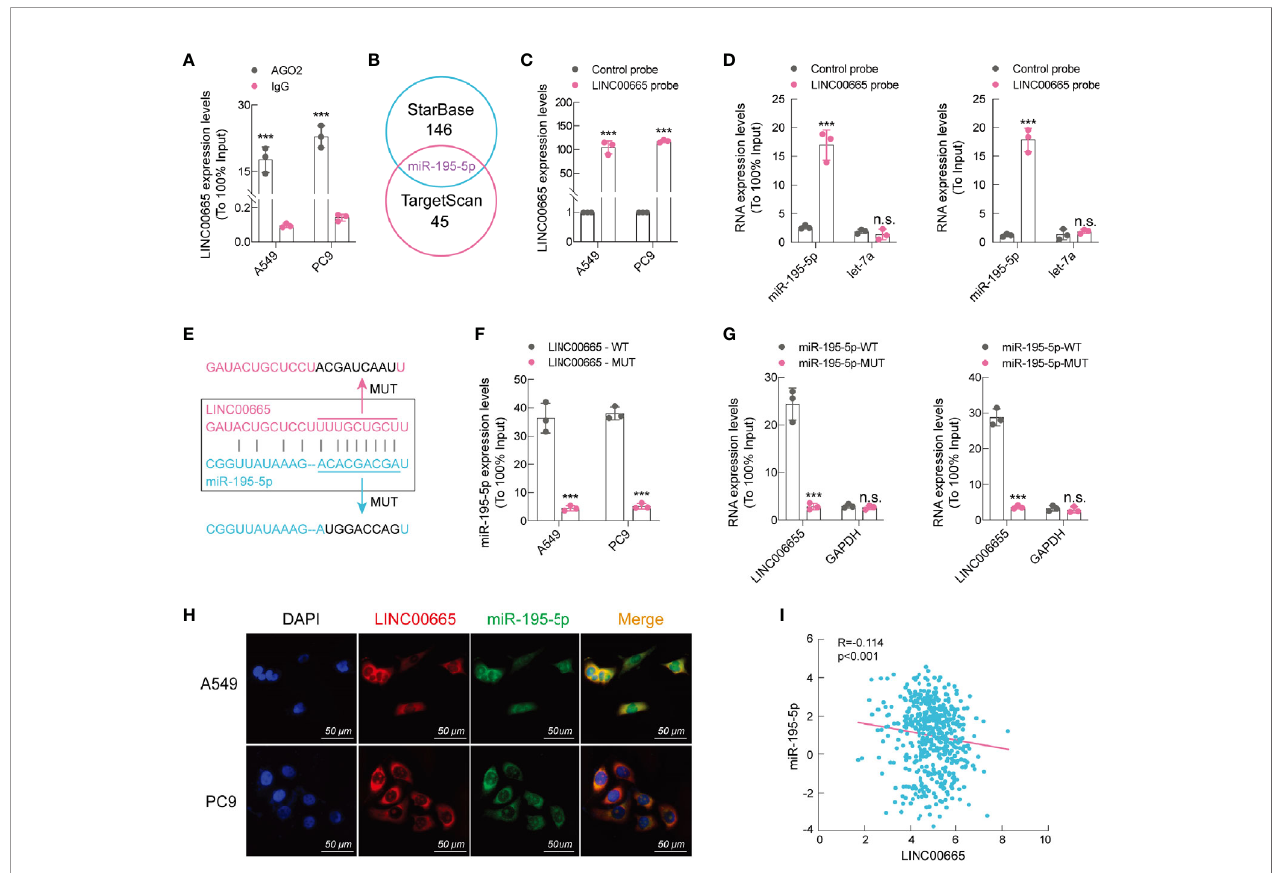
FIGURE 4 | LINC00665 is a sponge of miR-195-5p. (A) RIP assay performed using AGO2 antibody, IgG served as a negative control. (B) Venn diagram showing the intersection of miRNA lists. (C) qRT-PCR results indicating that LINC00665 could be speci fi cally enriched by the LINC00665 probe. (D) The relative expression levels of miR-195-5p and let-7 (negative control) detected using qRT-PCR in A549 and PC9 cell lysates. (E) Schematic graph illustrating the mutation of potential binding sites between LINC00665 and miR-195-5p. (F) miR-195-5p enriched by biotinylated wild-type or mutant LINC00665, and qRT-PCR used to determine the relative miR-195-5p levels. (G) LINC00665 enriched by biotinylated wild-type or mutant miR-195-5p, and qRT-PCR used to determine the relative miR-195-5p levels. (H) RNA FISH images showing the localization of LINC00665 and miR-195-5p in A549 and PC9 cells, scale bar, 50 m m. (I) Expression of LINC00665 and miR-195-5p that were negatively correlated (Data from TCGA). ***p < 0.001. n.s., no signi fi